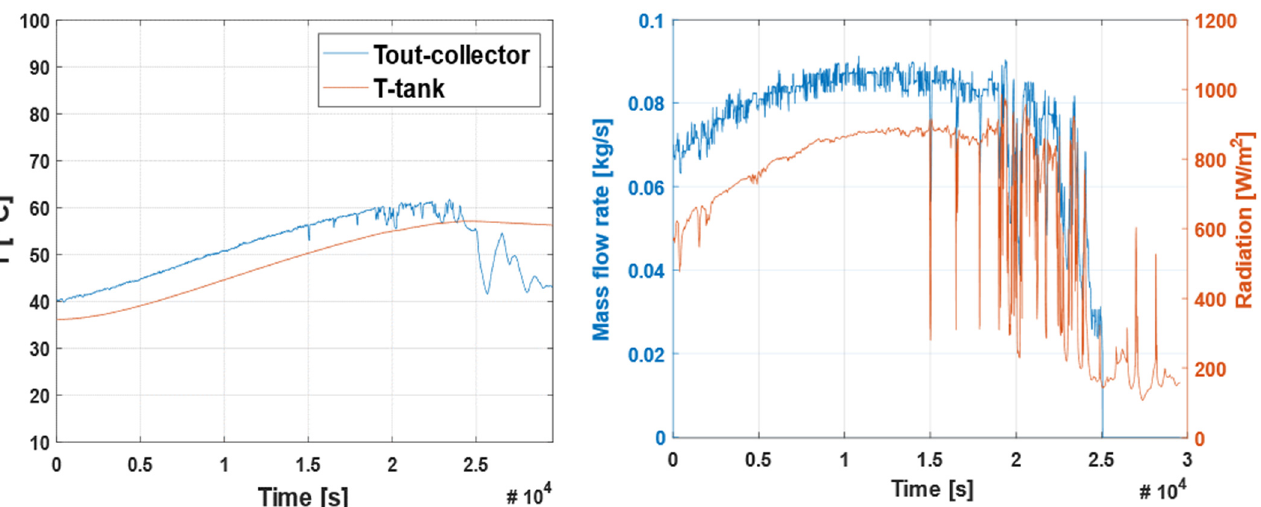
Figure 17. Measurement results of 30.05.